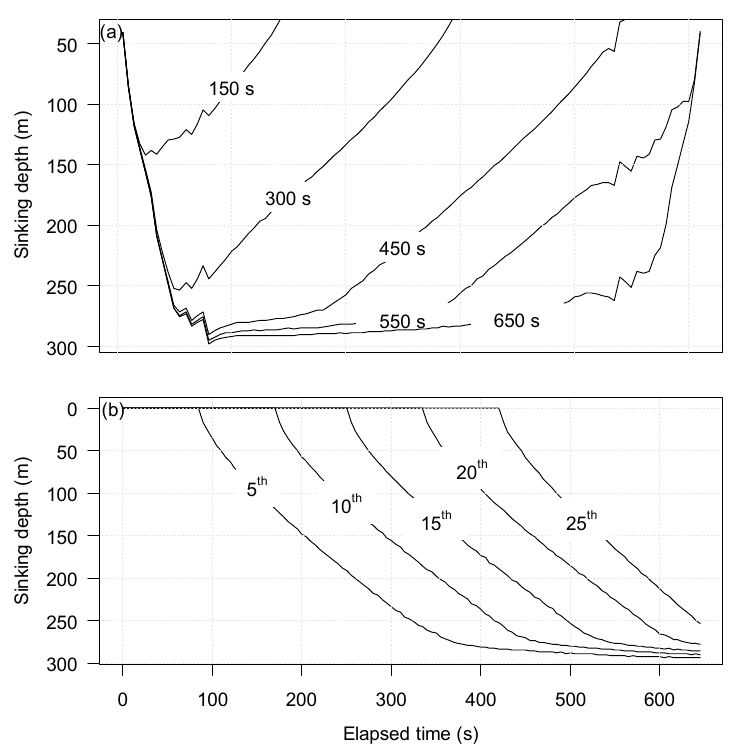
Figure 5. Sinking behavior without flow interference. ( a ) Vertical configuration and depth of lead line at time phases of 150 s, 300 s, 450 s, 550 s, and 650 s. ( b ) Changing sinking depth with elapsed time for the 5th, 10th, 15th, 20th, and 25th strips.